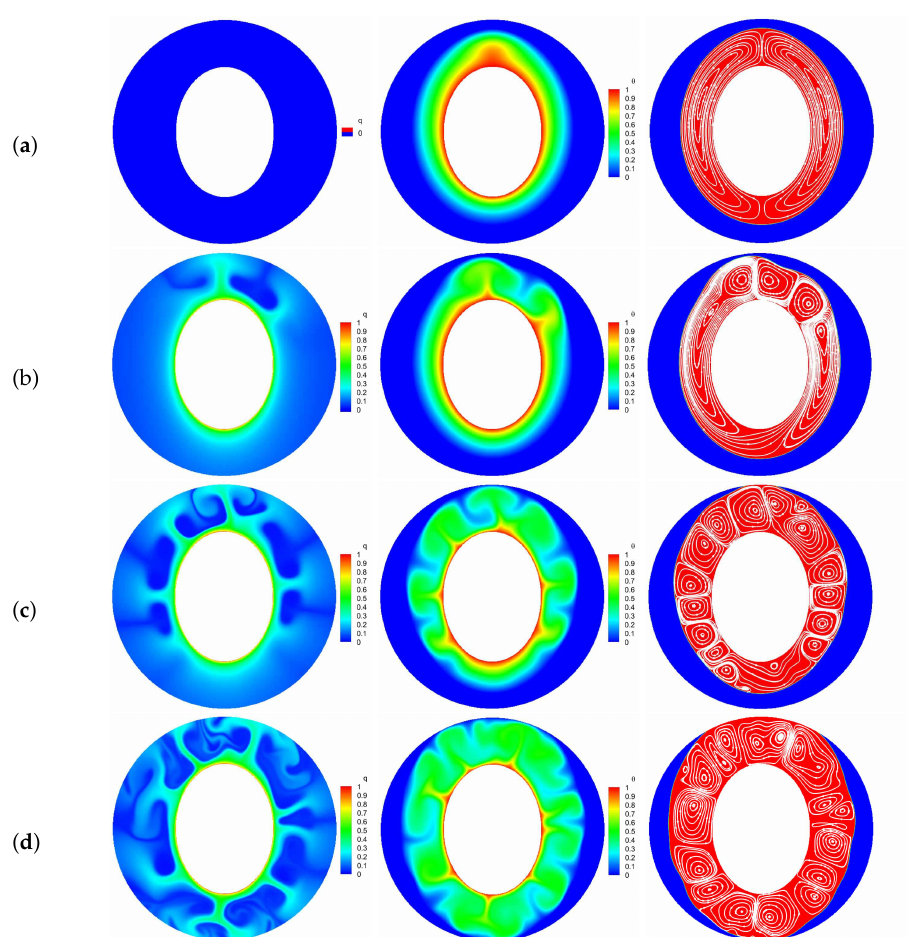
Figure 8. The transient distributions of charge density, temperature field and the liquid fraction with streamlines at Fo = 2.0 for different electric Rayleigh numbers (( a ) T = 0; ( b ) T = 250; ( c ) T = 350; ( d ) T = 500). Parameters: Ra = 10,000, AR =